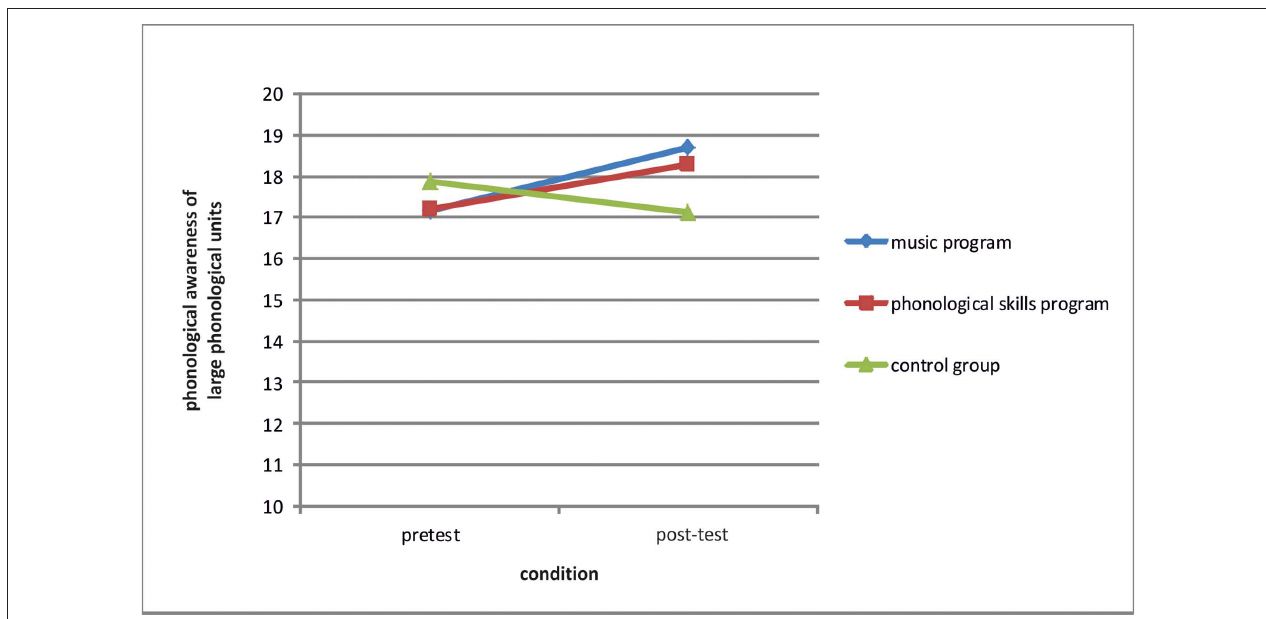
Figure 2 | Mean phonological awareness of large phonological units score at pre- and post-test in the music group, the phonological skills group, and the control